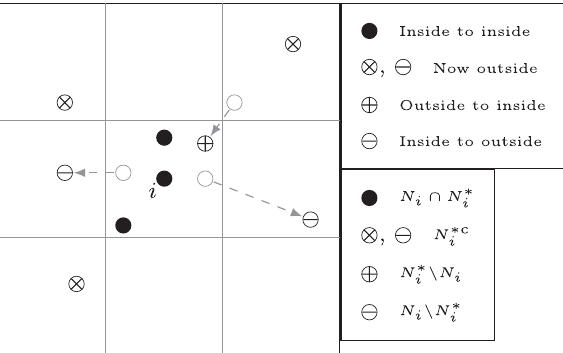
N (cid:4) are now in N (cid:4) c minus N , union N (cid:4) n N i i i n i i i